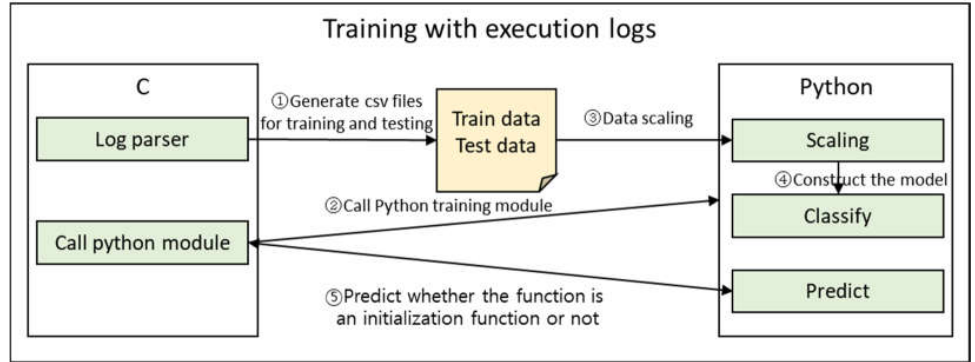
Figure 7. VVDUM (Variable Vulnerability Detector Using Machine learning).